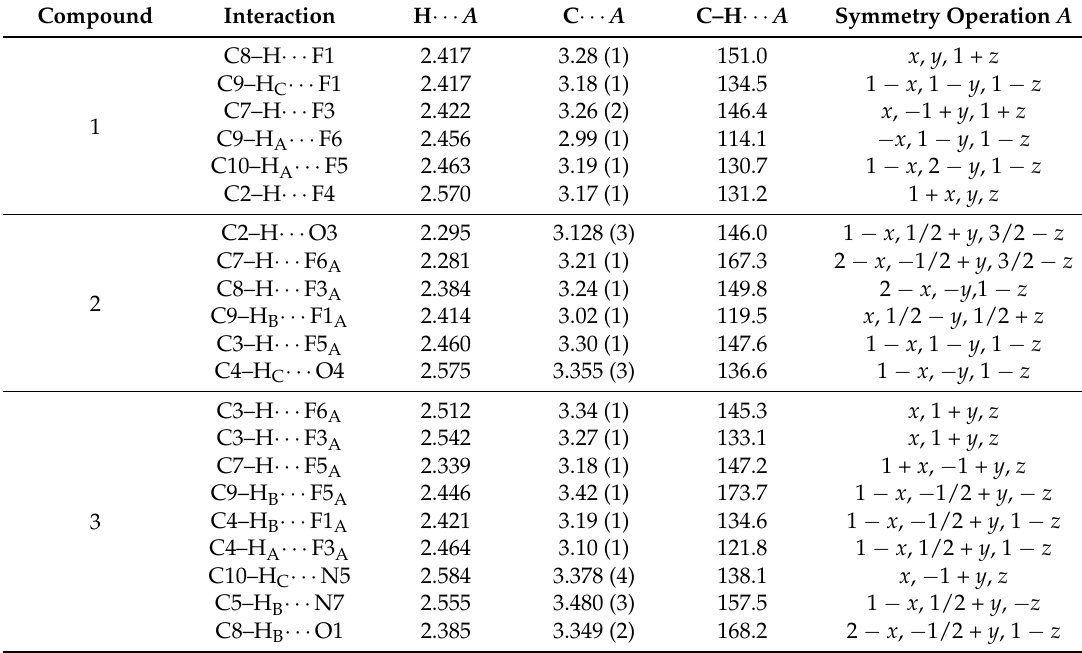
Table 2. Interactions for 1 – 3 (Å, ˝ ).